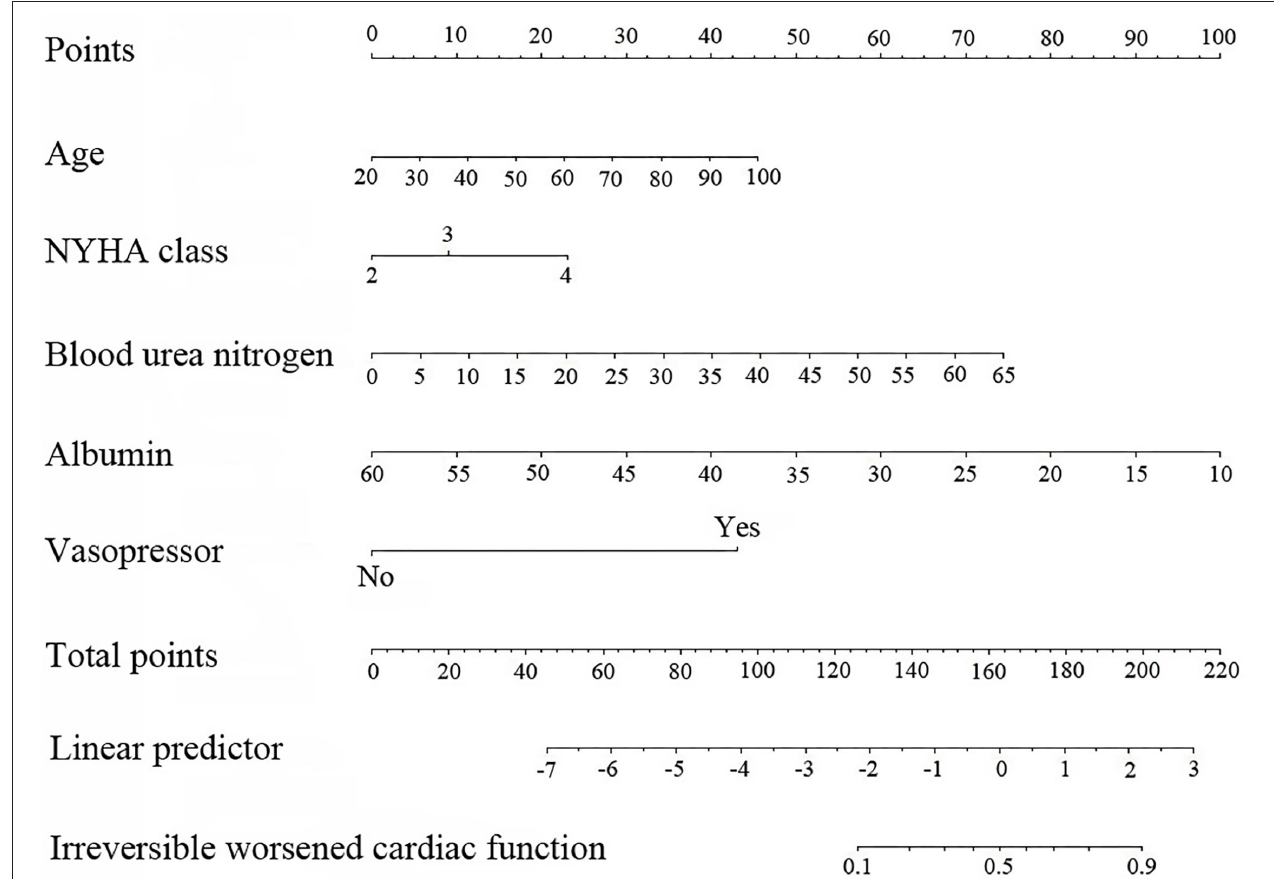
FIGURE 2 | Nomogram based on the results of for logistic regression model (age in years, blood urea nitrogen in g/L, and albumin in g/L).